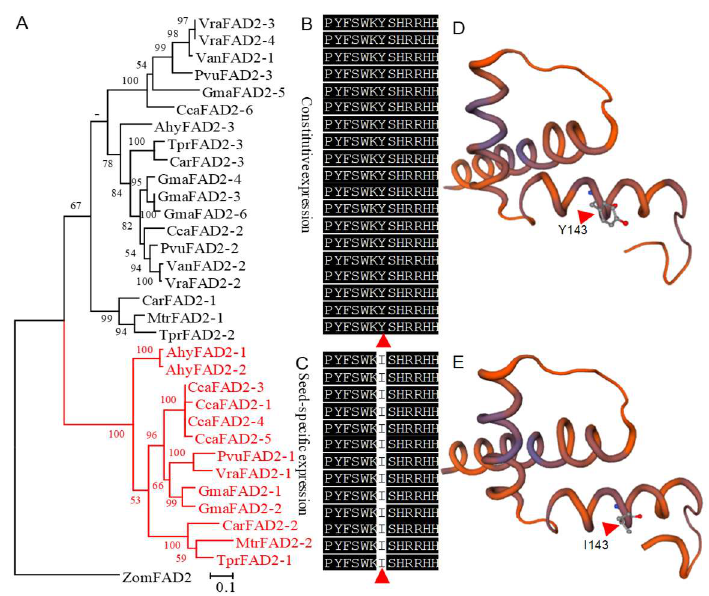
Figure 5. Phylogenetic relationship and structure of the FAD2 gene family in Fabaceae. ( A ) The phylogenetic tree of FAD2s in Fabaceae. ( B ) The Hisbox 2 in constitutive expression FAD2 genes. ( C ) The Hisbox 2 in seed-specific expression FAD2 genes. ( D ) The predicted spatial structure of partial GmaFAD2-1 with Y143. ( E ) The predicted spatial structure of partial GmaFAD2-1 with I143. The tree was constructed with ML methods based on the amino acid (aa) sequences with the ZomFAD2 as outgroup. The seed-specific clade was marked in red. The diverged 143 site was marked in red triangles.